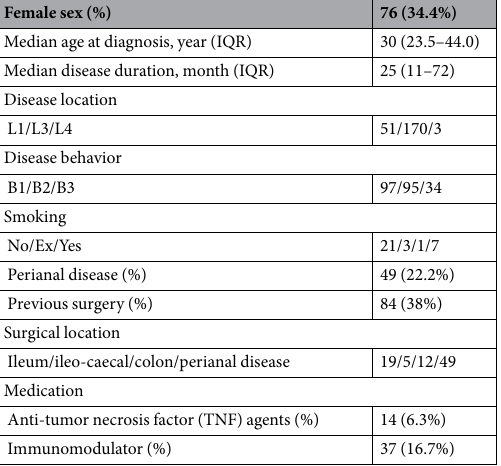
Table 1. Baseline demographic variables of study population. IQR: interquartile range; Disease Location: L1, ileitis; L2, colitis; L3, ileo-colitis; L4, upper gastrointestinal involvement; Disease behavior: B1, non-stricturing, non-penetrating; B2, structuring; B3,